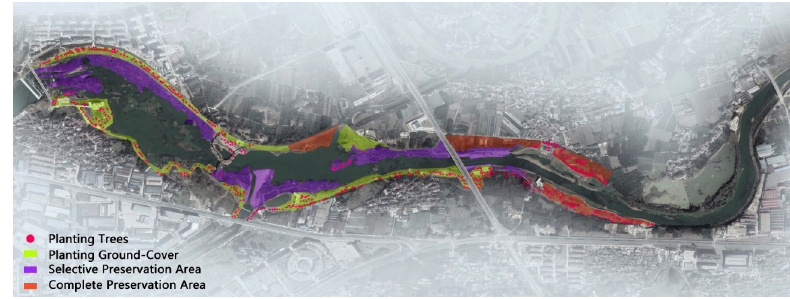
Figure 2. Vegetation preservation and planting planning